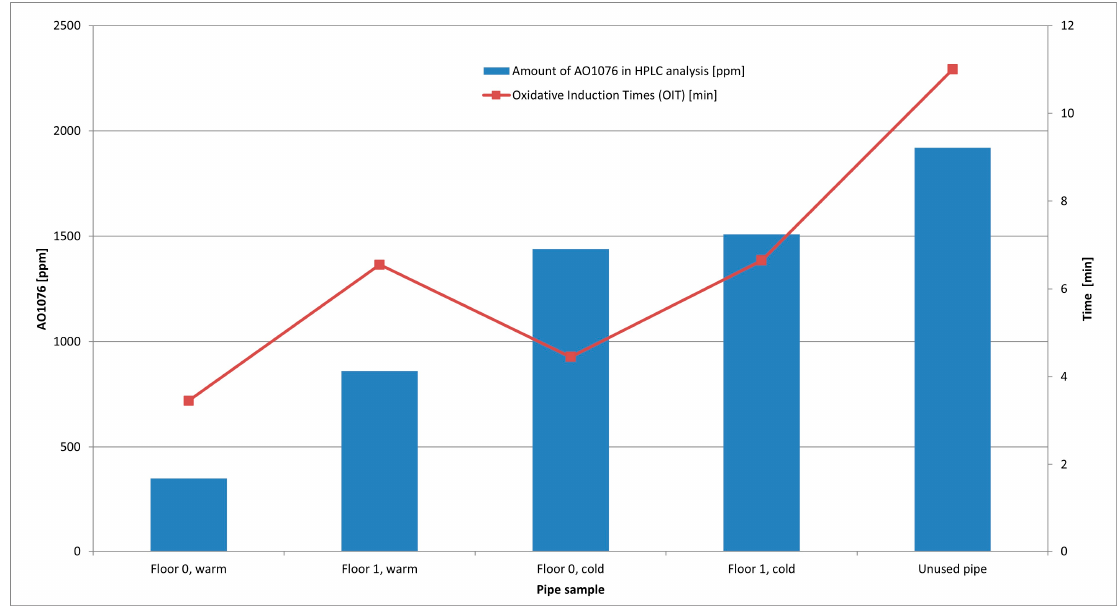
Figure 7. The Oxidative Induction Times (OIT) of the examined plastic pipe samples and the quantities (ppm) of antioxidant determined AO1076 by